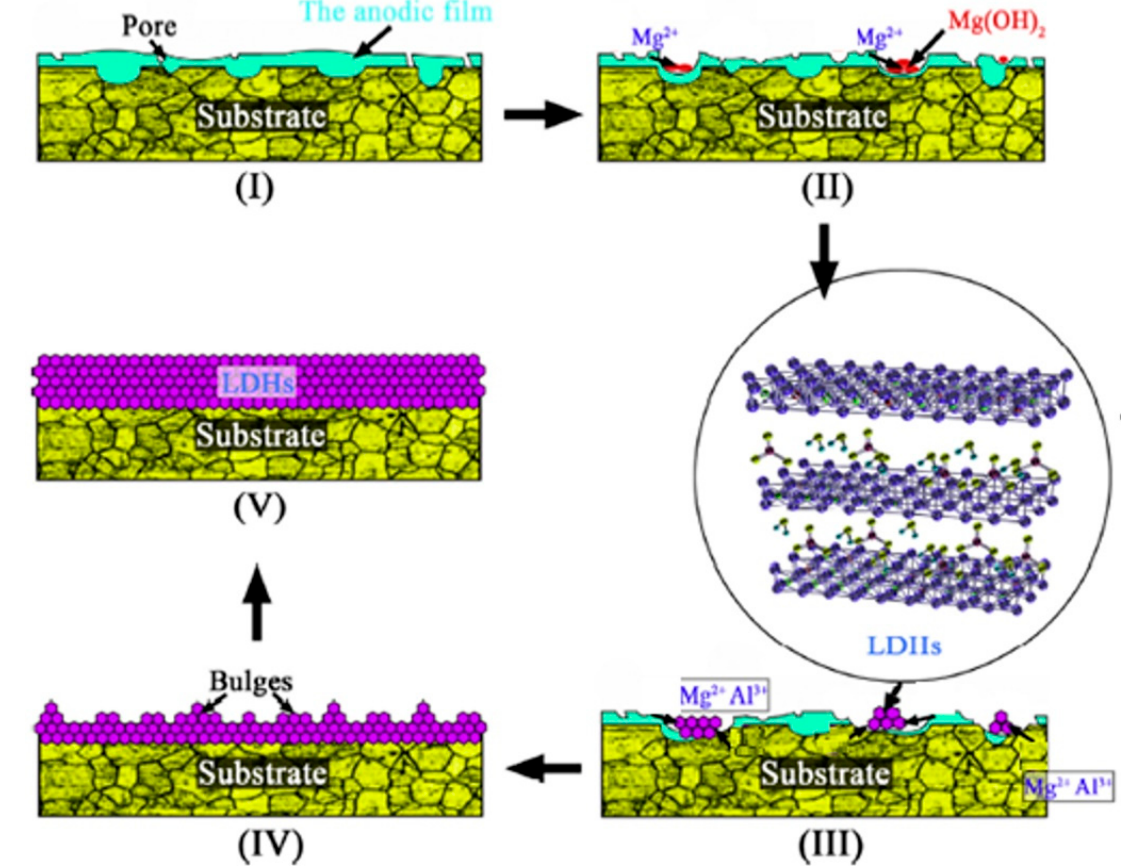
Figure 2. Schematic diagram of the transformation process of anodized film into LDH film. Reprinted with permission from ref. [55]. Copyright 2018 Elsevier.